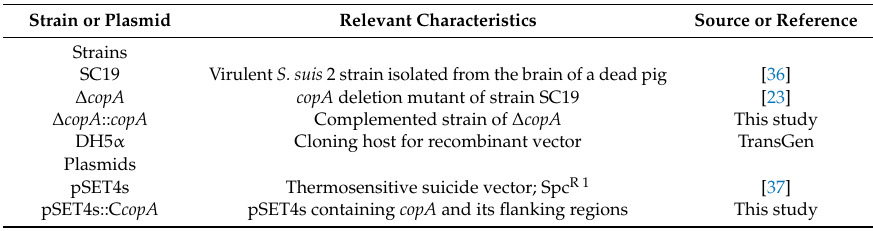
Table 2. Bacterial strains and plasmids used in this study.